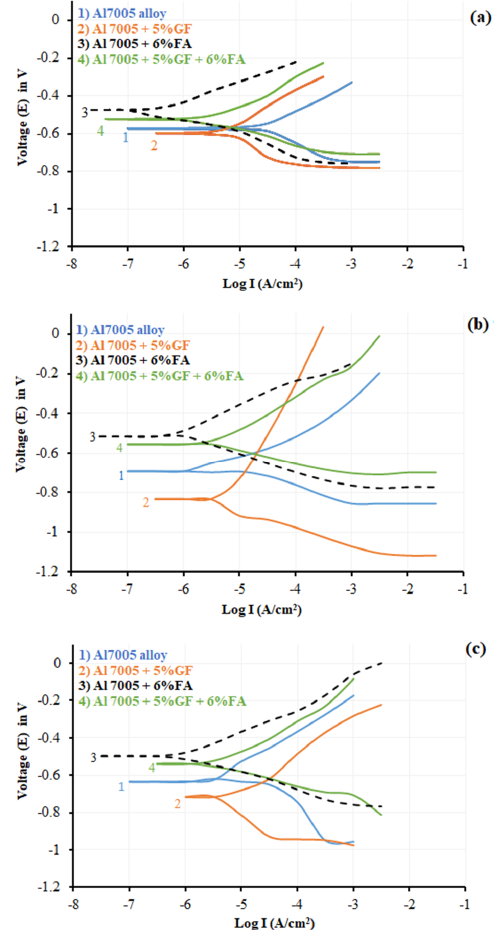
Figure 5. Polarization curves of Al 7075 and its composites: ( a ) as-cast, ( b ) ER: 2.66:1, and ( c ) ER: 5.32:1. During testing the specimens, the hydrolysis phenomenon and electrochemical ag- gression occur simultaneously at the interface in the case of glass fibre-reinforced alumin- ium composites. An increase in voltage tends to damage the glass fibre and matrix inter- face severely. Hydrolysis acid creates pits, cracks, flakes and blisters that degrade the fi- bre–matrix interface [81]. Conversely, the corrosion current in fly ash-based composites is shown to be lower than that of other materials. The anodic curves of Al 7005 showed the continuity curves indicating the susceptibility of pitting corrosion. The fly ash particles improve the corrosion resistance to Al 7005 due to the following: FA particles remain inert or non-reactive, and fly ash absorbs the chlorine ions onto the oxide layer and produces a more stable layer on the aluminium alloy, and secondly, this alters the microstructure and